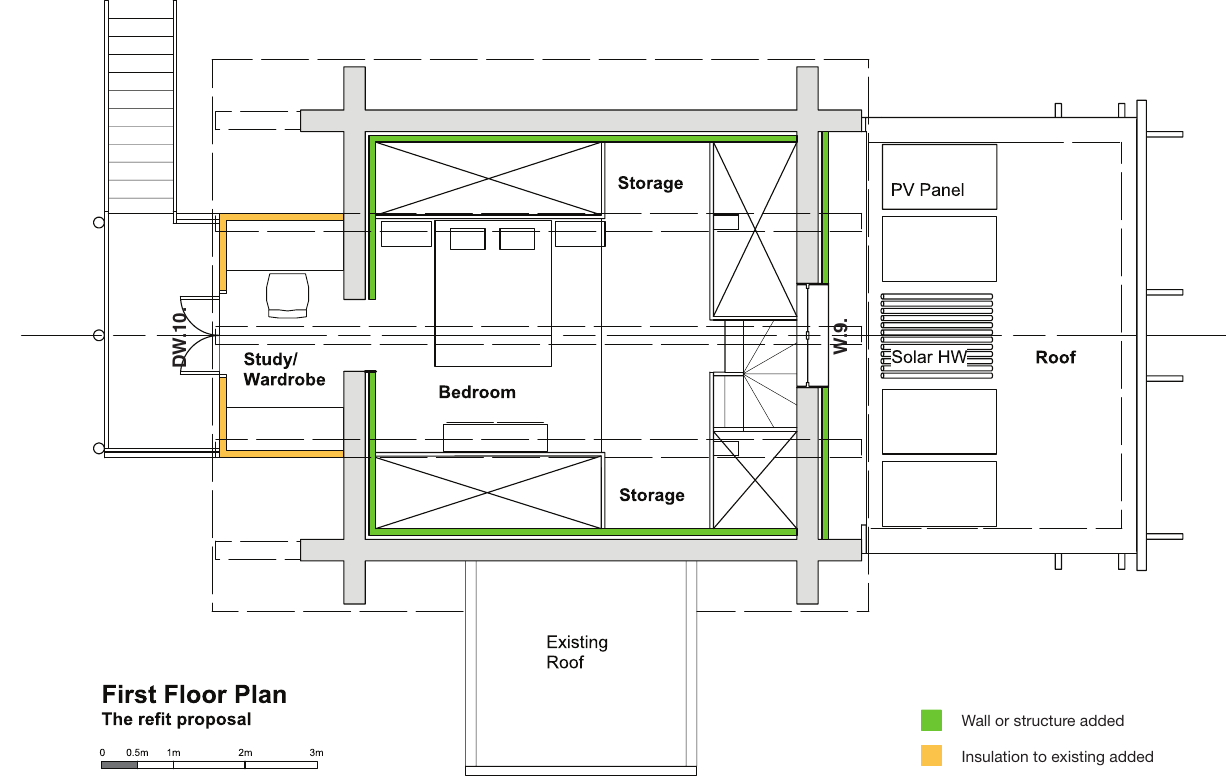
Figure 3. The students’ renovation concept: First floor